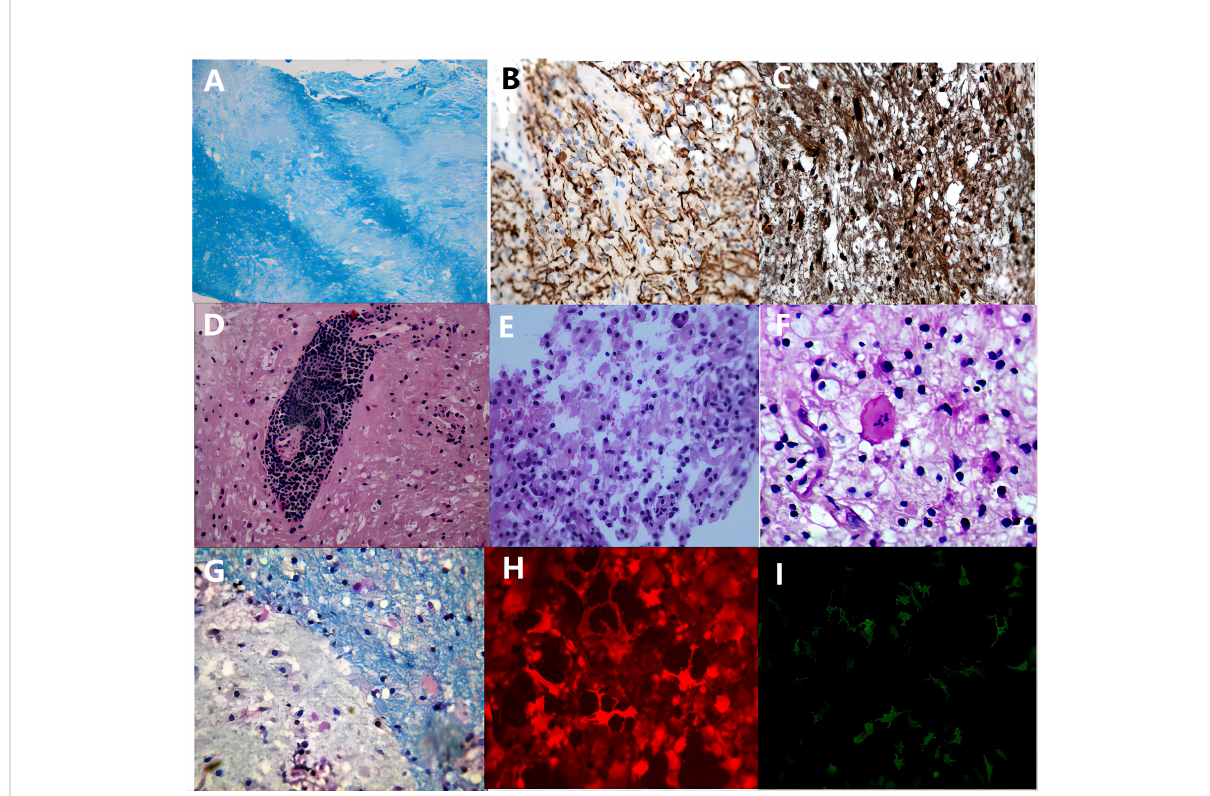
FIGURE 1 The pathological manifestations of TDLs. The in fl ammatory demyelinating lesions in 72 patients had the following characteristic manifestations: All patients had myelin loss, a laminar structure between myelin loss and myelin preserved area was seen in Balo patients (A) , luxol-fast blue, x200); a few patients with severe CNS in fl ammation had a reduced number of axons and relatively preserved axons (B) , neuro fi lament, x200); most patients had preserved but swollen axons (C) , neuro fi lament, x200); lymphocyte “ sleeve ” around the blood vessels (D) , haematoxylin- eosin, x200), and a considerable number of foam cells (E) , haematoxylin-eosin, x200) and some Creutzfeldt cells (F) , haematoxylin-eosin, x200) are observed in the acute phase; in the chronic phase, in fl ammatory cells gradually migrate to the edge of the lesion (G) , luxol-fast blue, x400). In NMOSD and MOGAD patients, the serum immuno fl uorescence stain is positive for AQP4-IgG (H) and MOG-IgG (I) ,